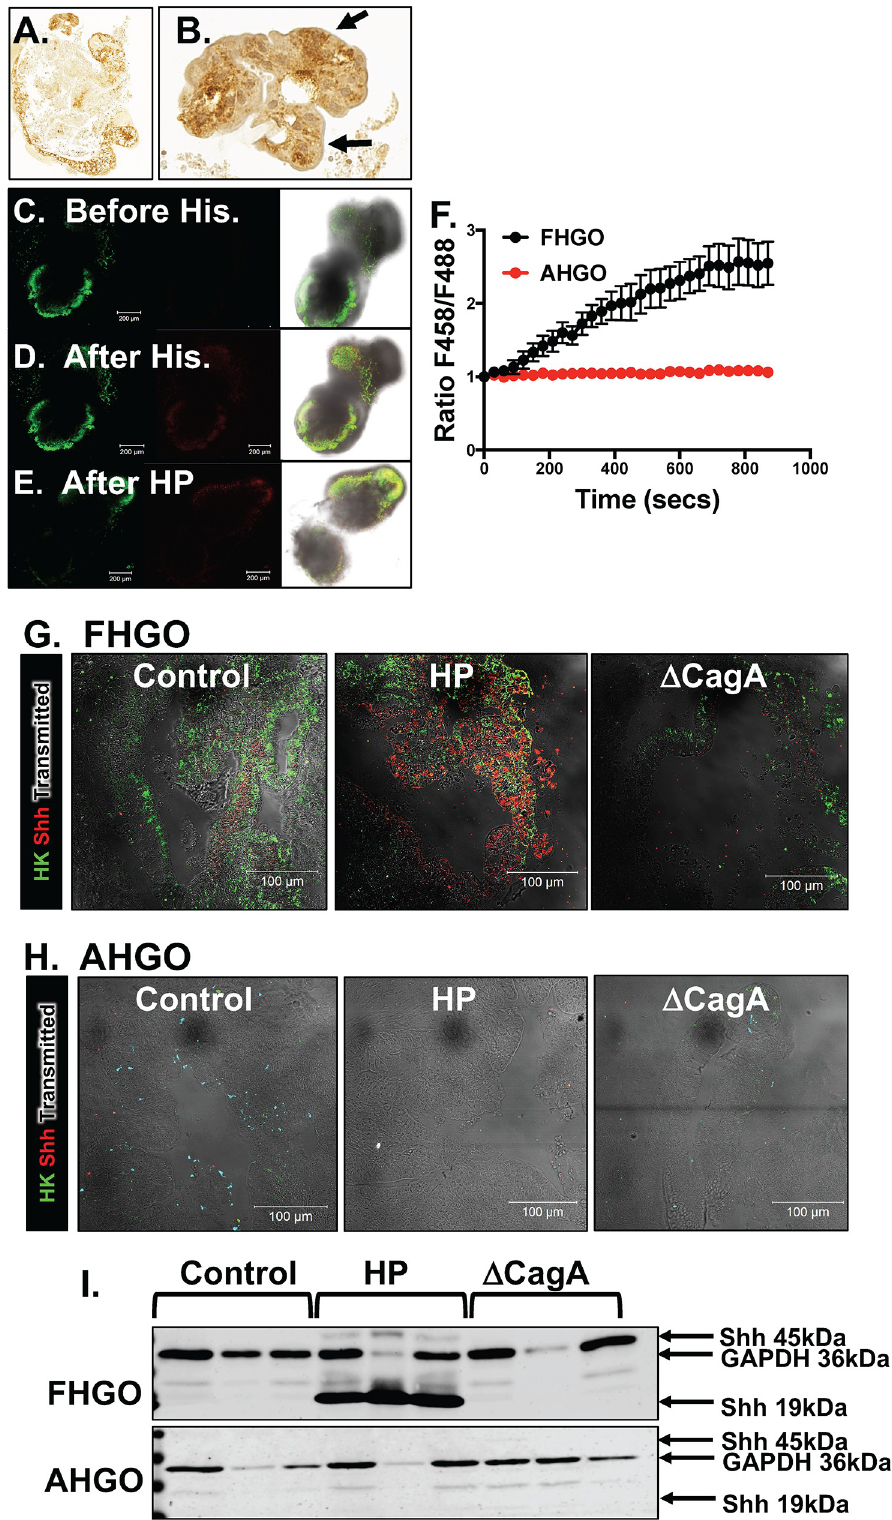
Fig 4. Phenotypic characterization of parietal cells in FHGOs and AHGOs. (A) Immunohistochemistry of H+/K + ATPase in sections collected from FHGOs. Higher magnification shown in (B). Acridine orange accumulation